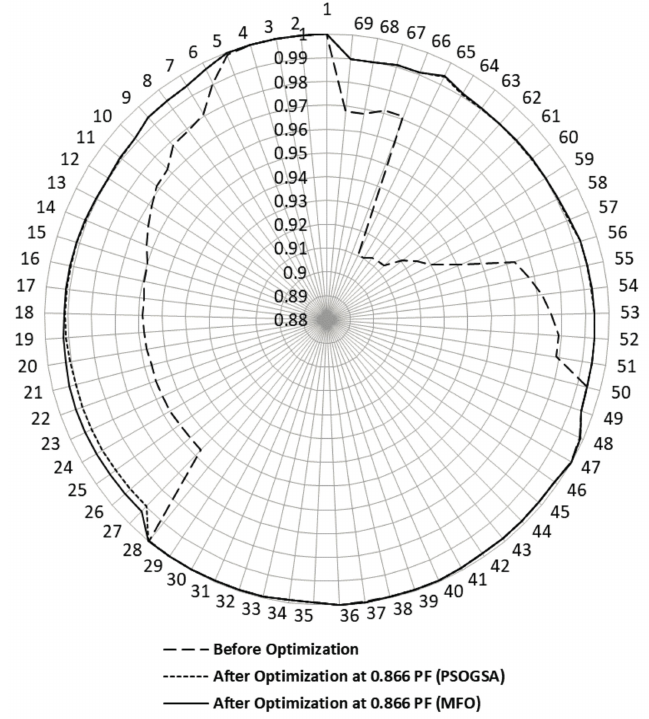
Figure 23. The impact of compensated devices on voltage profile for 69-bus IEEE system at 0.866